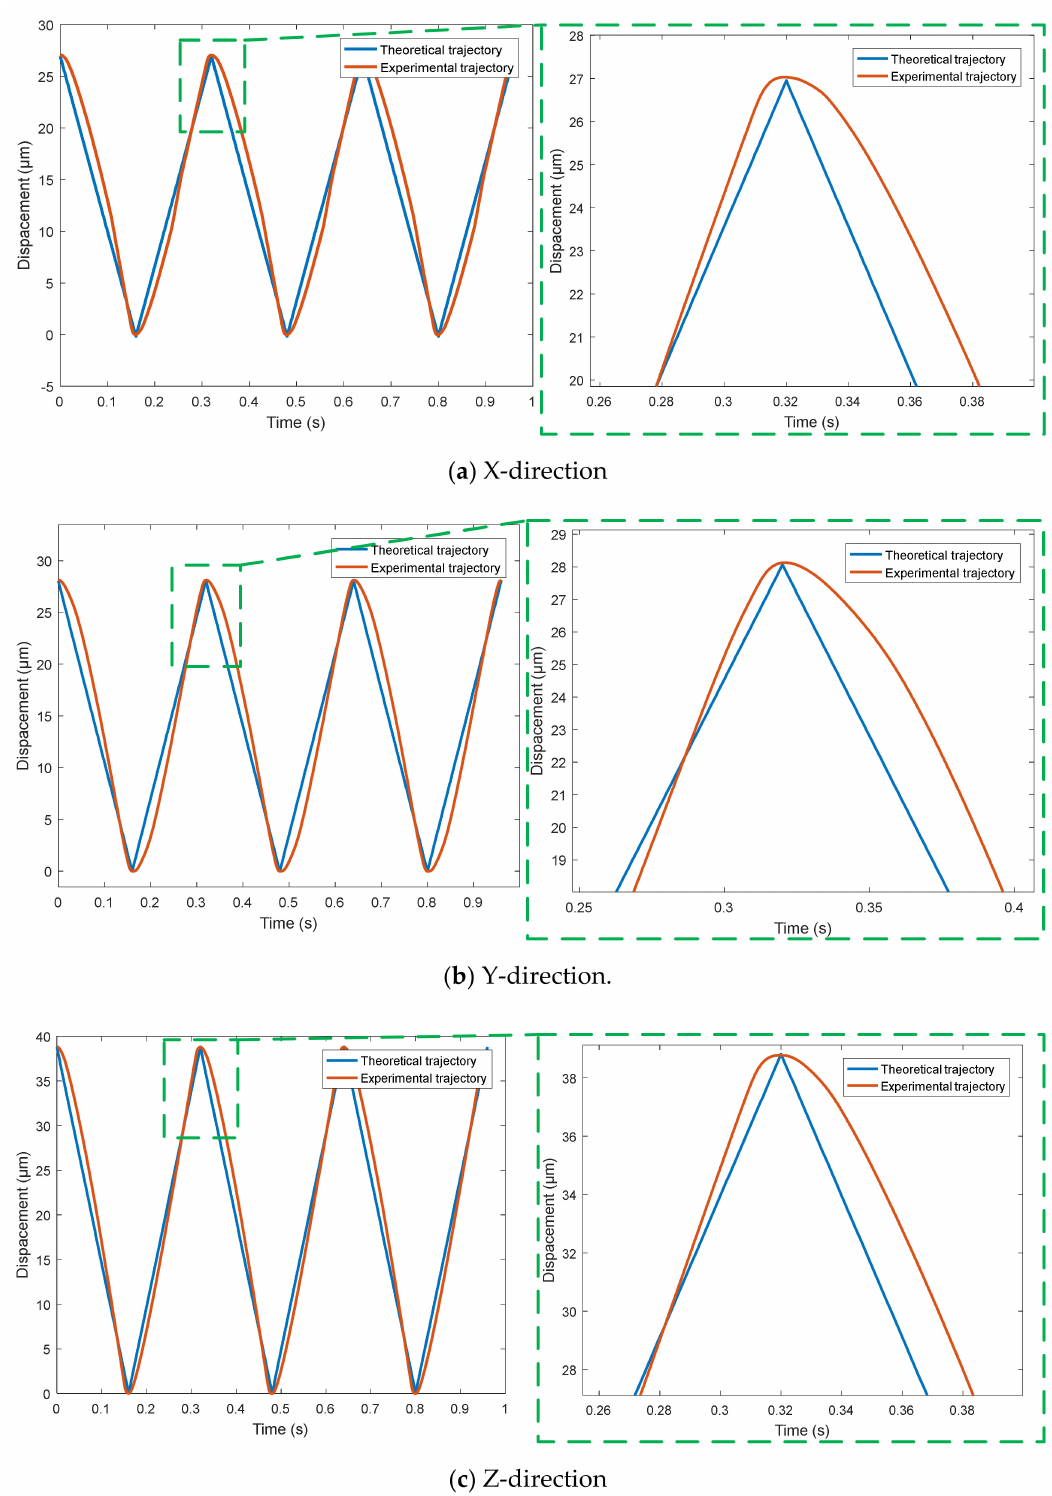
Figure 10. Trajectory tracking performance of triangular wave